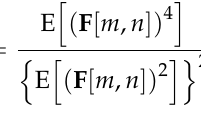
Figure 5. The red lines indicate the kurtosis with a subject and the black lines without a subject. The distances between the antenna and test subject are 3 m, 6 m, 9 m, and 11 m. These results indicate that the kurtosis is negative when a subject is present, and near zero without a